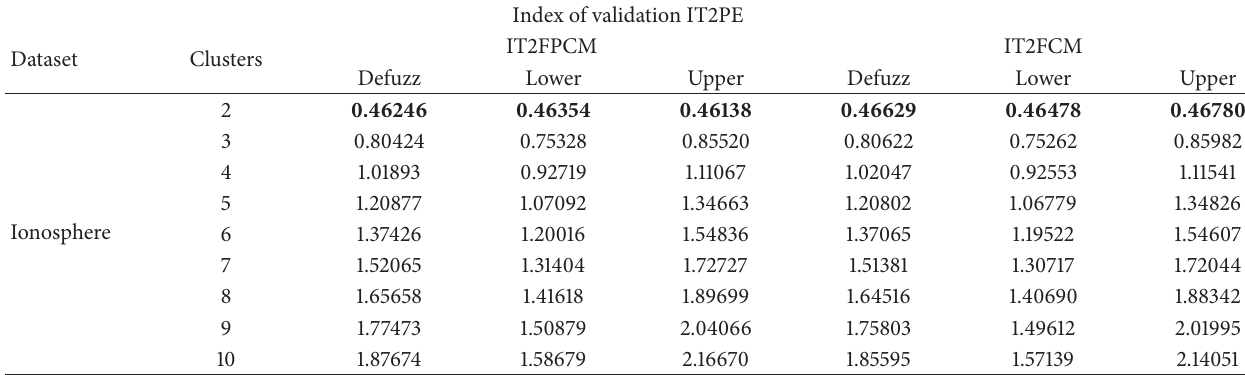
Table 14: Results of the IT2PE validation index to Ionosphere dataset clustering using IT2FPCM and IT2FCM algorithm with 𝑚 = [1.5, 2.5] and 𝜂 = [1.5, 2.5] as parameters.